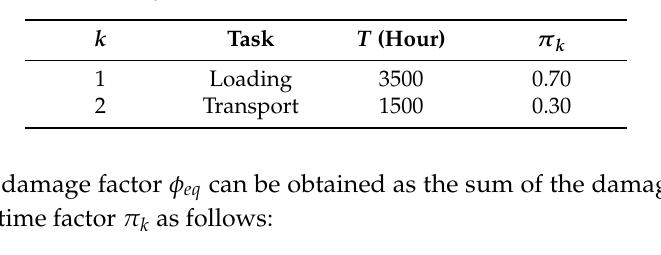
Table 2. Cylinder data from the machine manufacturer.